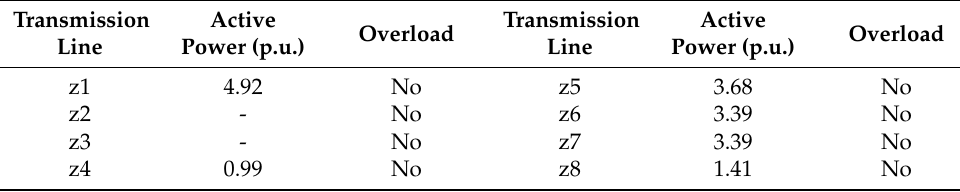
Table 6. Operation status of transmission lines in the five-bus system.